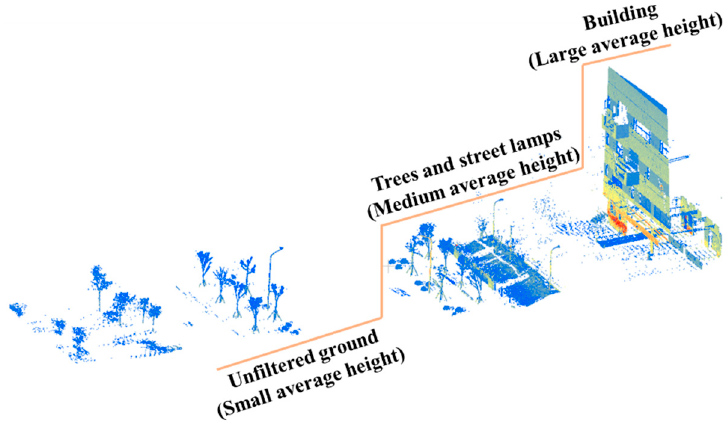
Figure 5. Average heights of different ground objects.